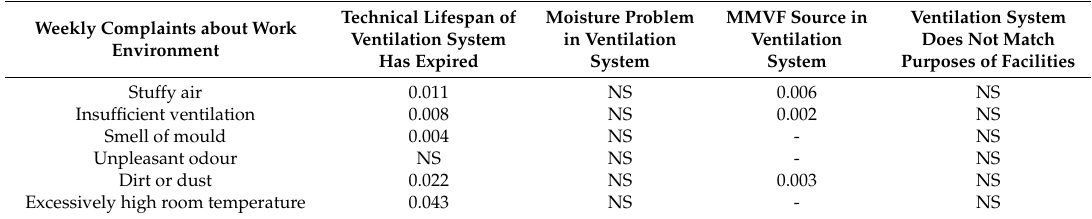
Table 7. Statistical differences ( p -value) between employees’ weekly complaints about their work environment and ventilation factors (yes/no)